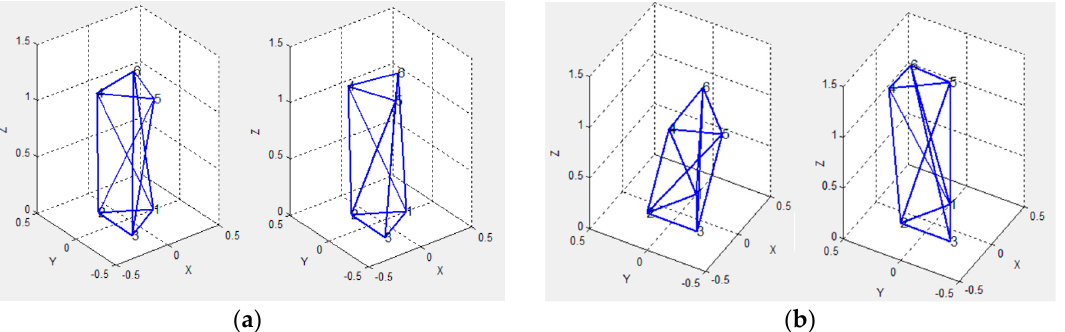
Figure 5. The identified type of the natural modes for all prestress levels: ( a ) the rotational mode; ( b ) the flexural mode.